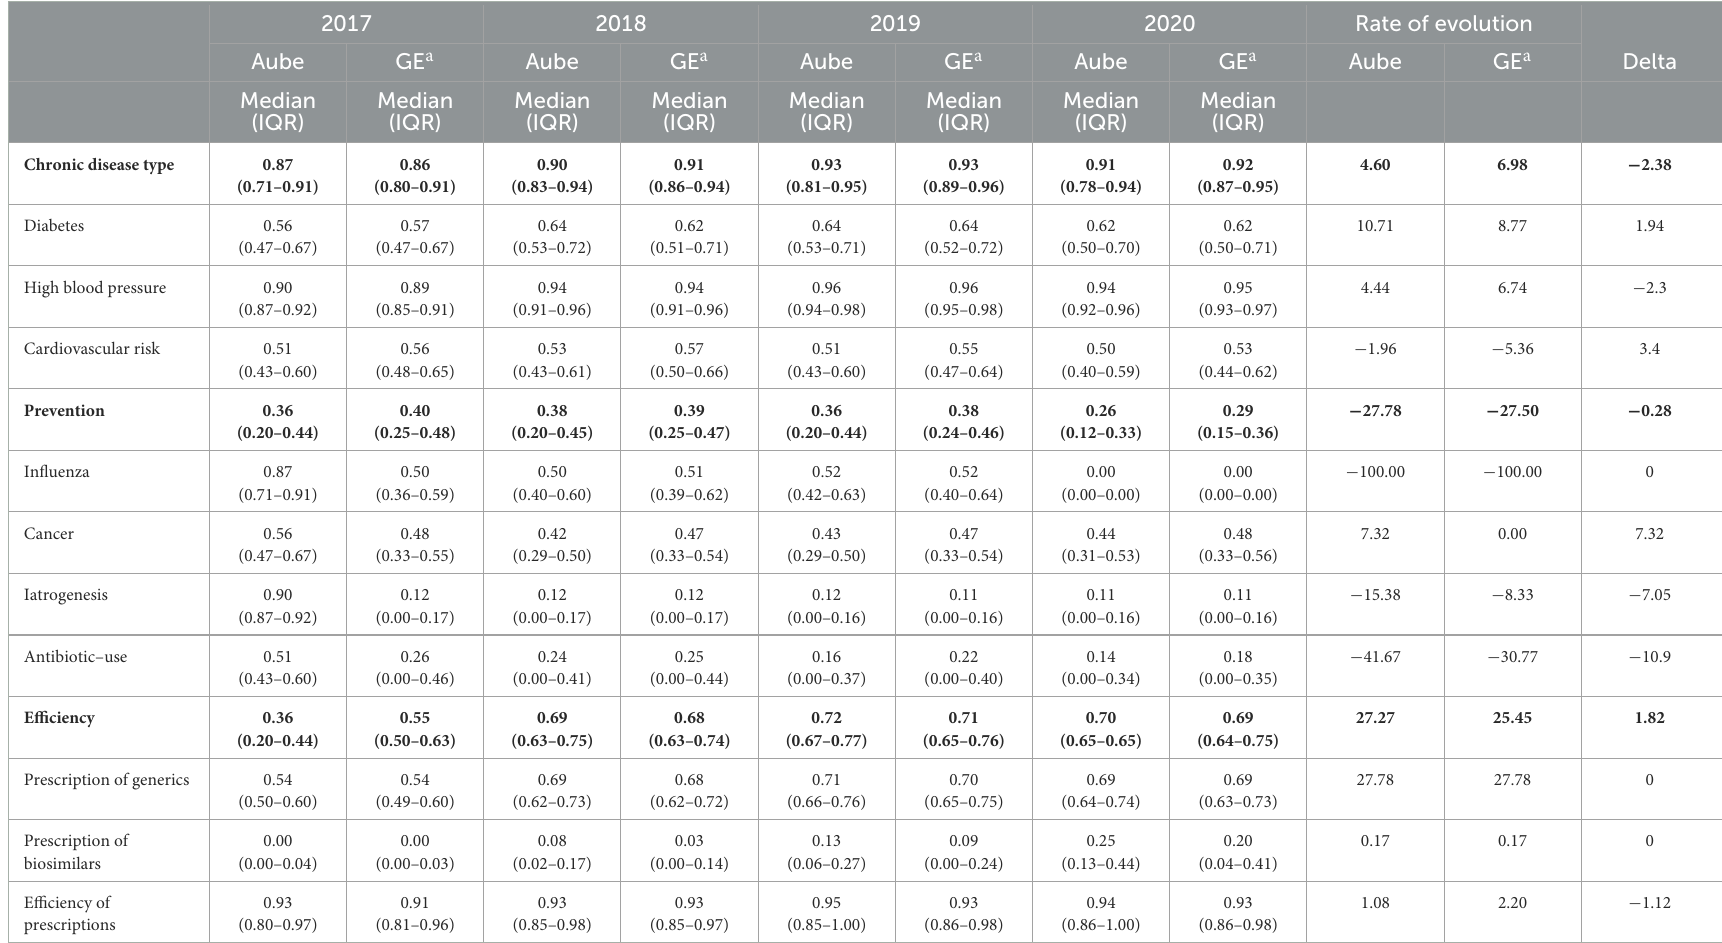
TABLE 1 Changes in ROSP scores between 2017 and 2020 in the Grand–Est region, between Aube and the rest of the Grand Est